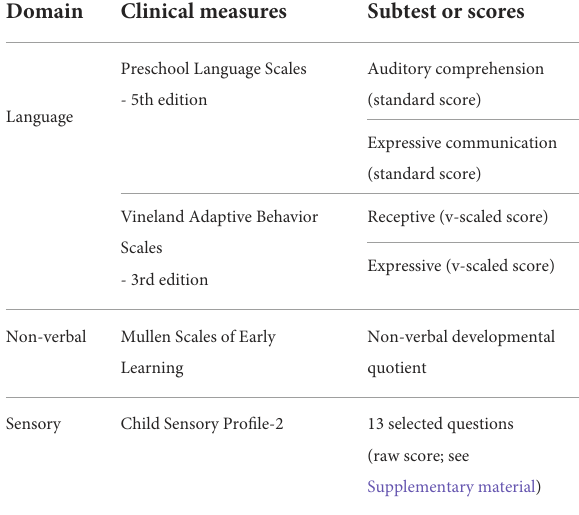
TABLE 2 Clinical measures collected from